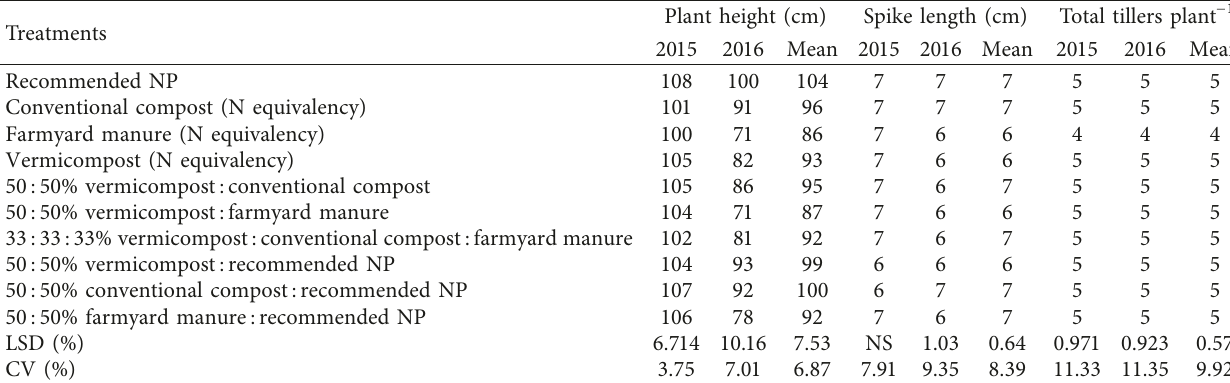
Table 1: Effects of the integrated use of organic and inorganic fertilizers on plant height, spike length, and total number of tillers plant − 1 of barley in 2015-2016 cropping seasons on smallholder farmers’ fields in Chelia district. Treatments